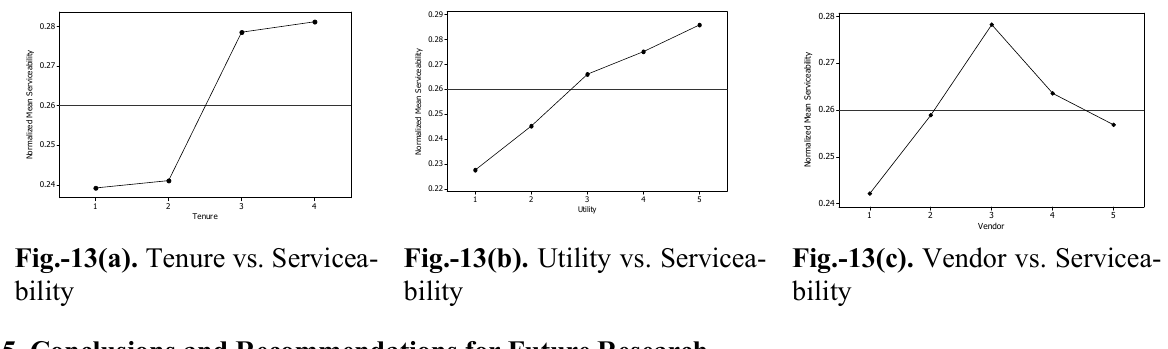
Fig.-13(a). Tenure vs. Servicea- bility